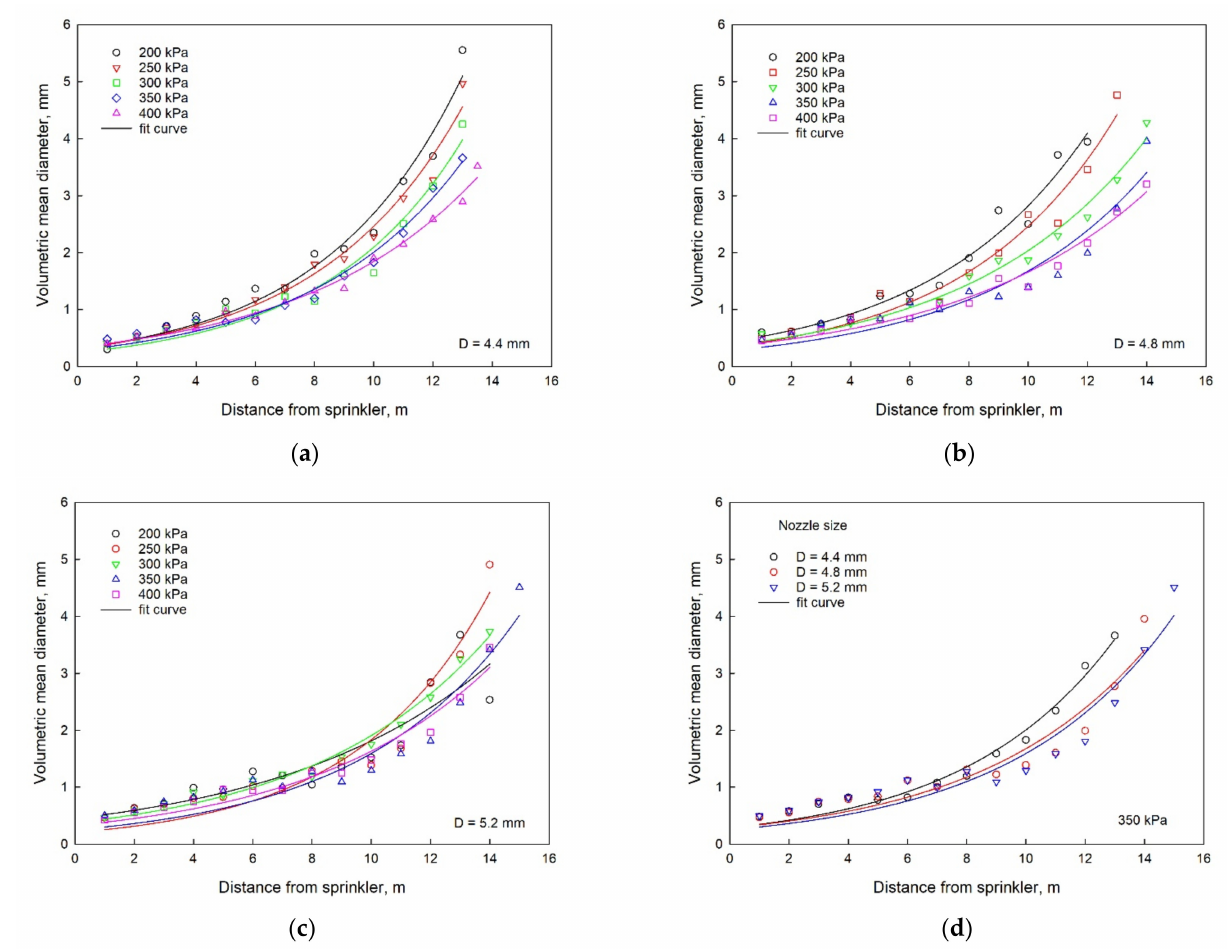
Figure 3. Relationships between the VMD and distance from the sprinkler under three different nozzle sizes of ( a ) D = 4.4 mm, ( b ) D = 4.8 mm, ( c ) D = 5.2 mm, and nozzle size of ( d ) under the working pressure of 350